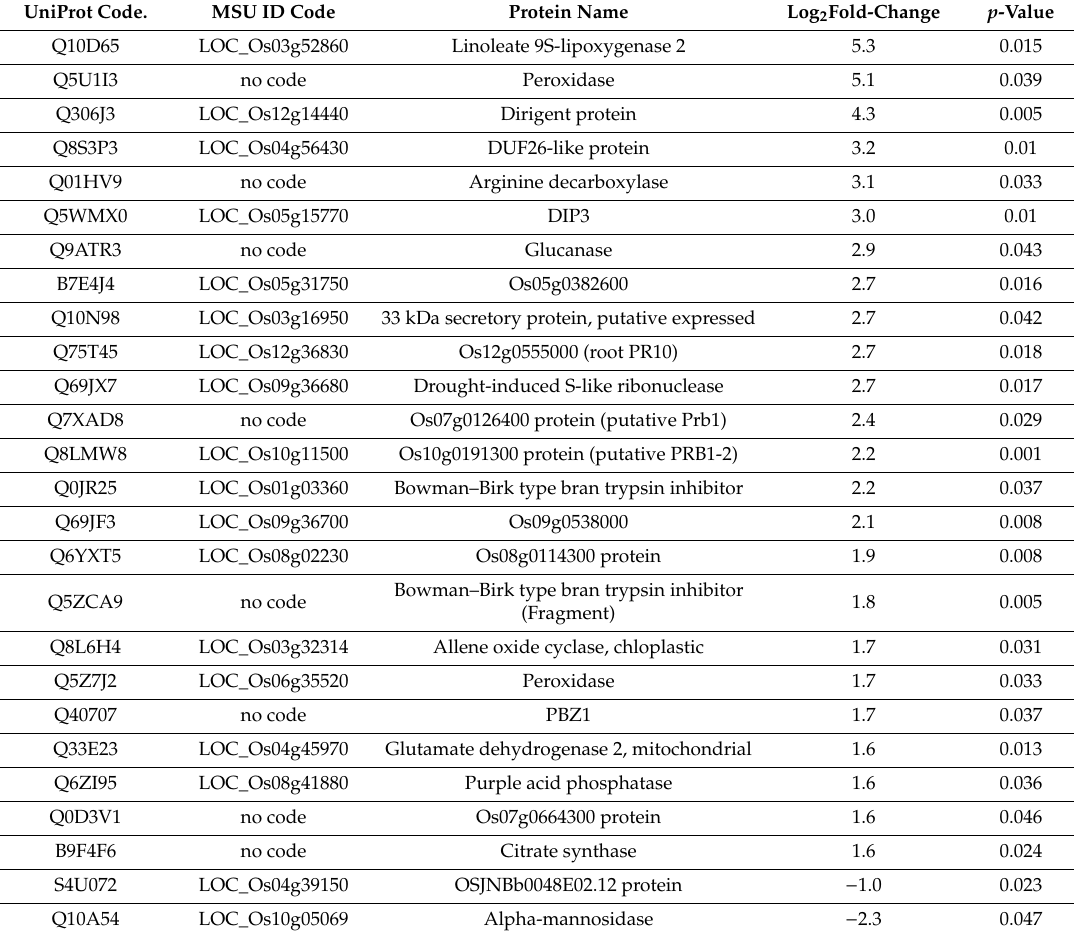
Table 3. Di ff erentially expressed proteins (DEPs) after MeJA treatment followed by wounding, compared to mock.